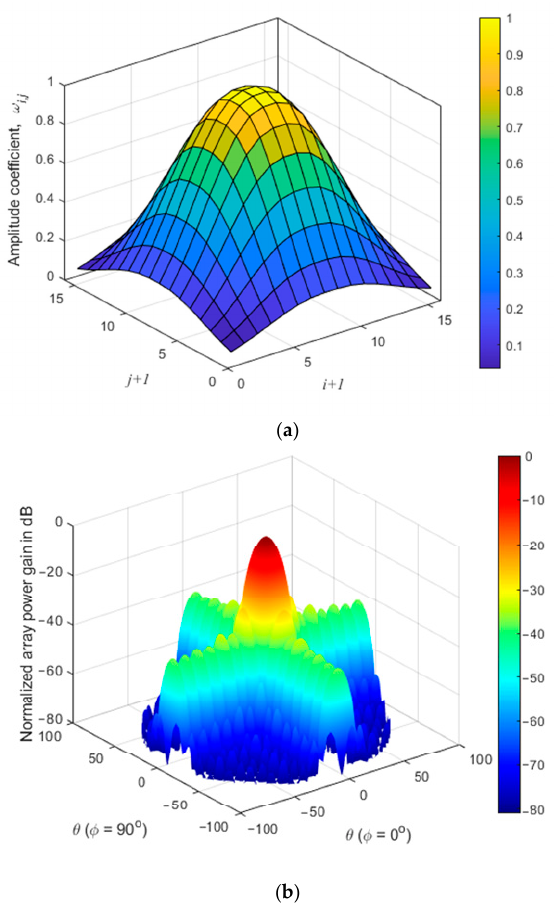
Figure 5. ( a ) 2D cross-linear extrapolated Hamming window for 16 × 16 array. ( b ) Normalized array power pattern.